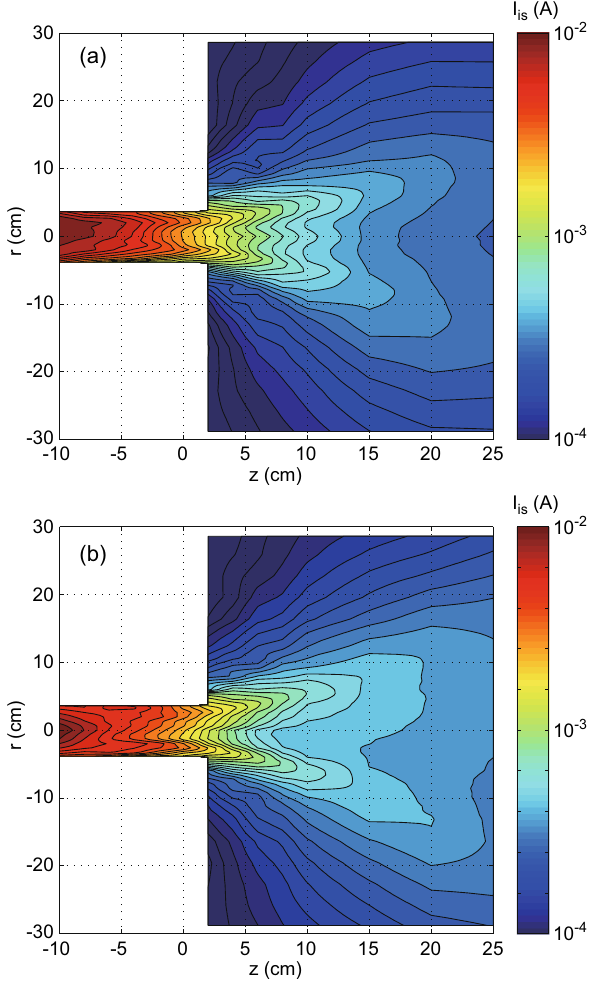
Figure 6. Two-dimensional profiles of the ion saturation current I is of the Langmuir probe taken at the rf power 0 mode cases. For both the cases, the plasma expands in the 4 kW for the ( a ) m 1 and ( b ) m of P rf = = = + magnetic nozzle and the density decay along the axis can be seen, where the density decay along the axis for the 0 mode 1 mode case seems to be conspicuous, compared with the m m = = +